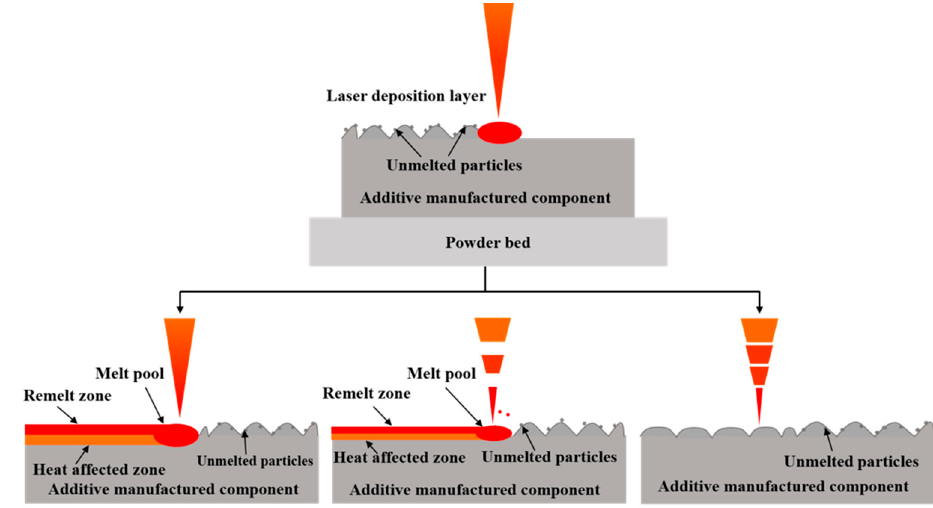
Figure 5. Schematic illustrating the laser polishing with di ff erent pulse widths.